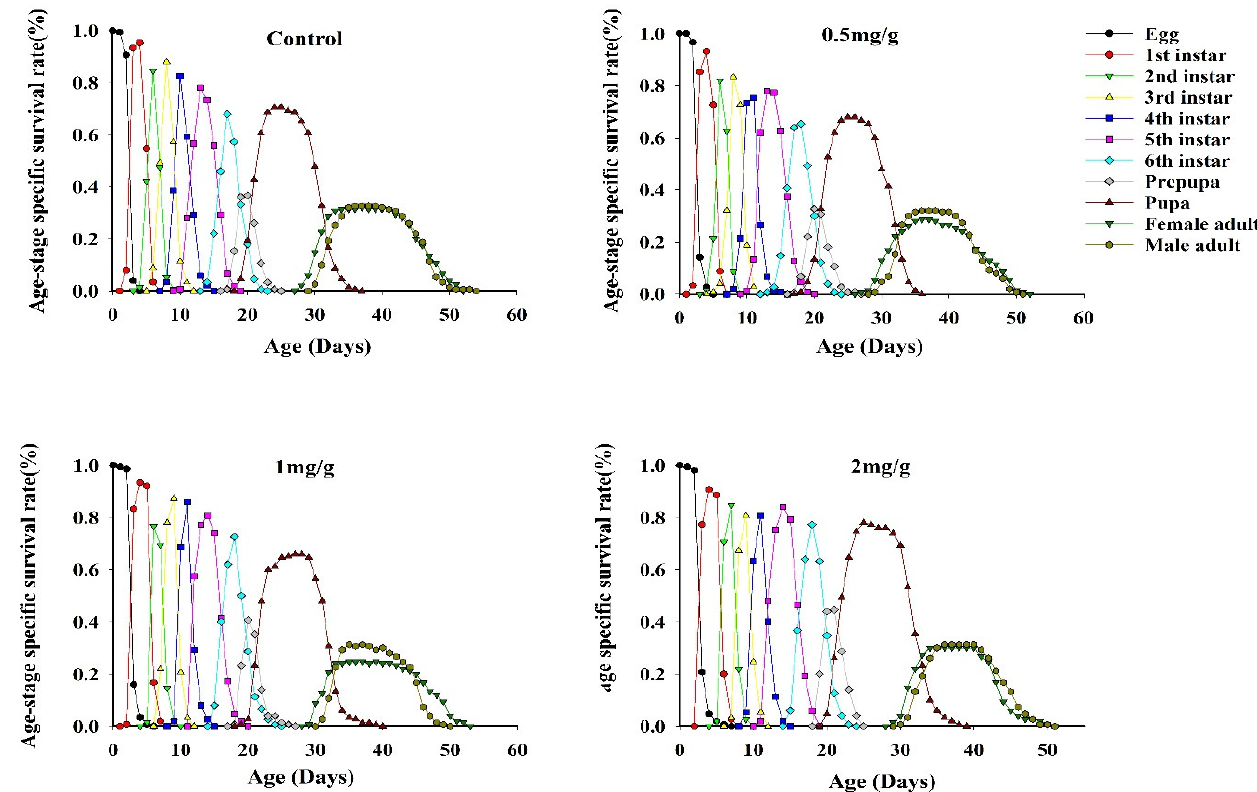
Figure 3. Age-stage-specific survival rates of Spodoptera frugiperda at different GO concentrations. Table 5. Survival rate at each life stage of Spodoptera frugiperda fed on GO. Life